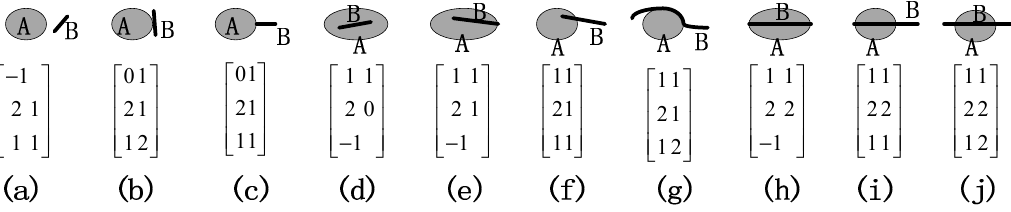
Figure 13. The line/region coarse relations with a single intersection distinguished by the Euler number-based whole object intersection and difference (E-WID) model. ( a ) Region A and line B are disjoint; ( b ) The zero-dimensional intersection is inside of line B ; ( c ) The zero-dimensional intersection is on the boundary of line B ; ( d ) Line B is contained by region A ; ( e ) Line B is covered by region A , but only one endpoint is on the boundary of A ; ( f ) Line B overlaps with region A, but there is no endpoint on the boundary of A ; ( g ) The one-dimensional intersection is on the boundary of region A ; ( h ) Line B is covered by region A and its endpoints are both on the boundary of A ; ( i ) Line B overlaps with region A and has one endpoint on the boundary of A ; ( j ) Line B crosses region A .